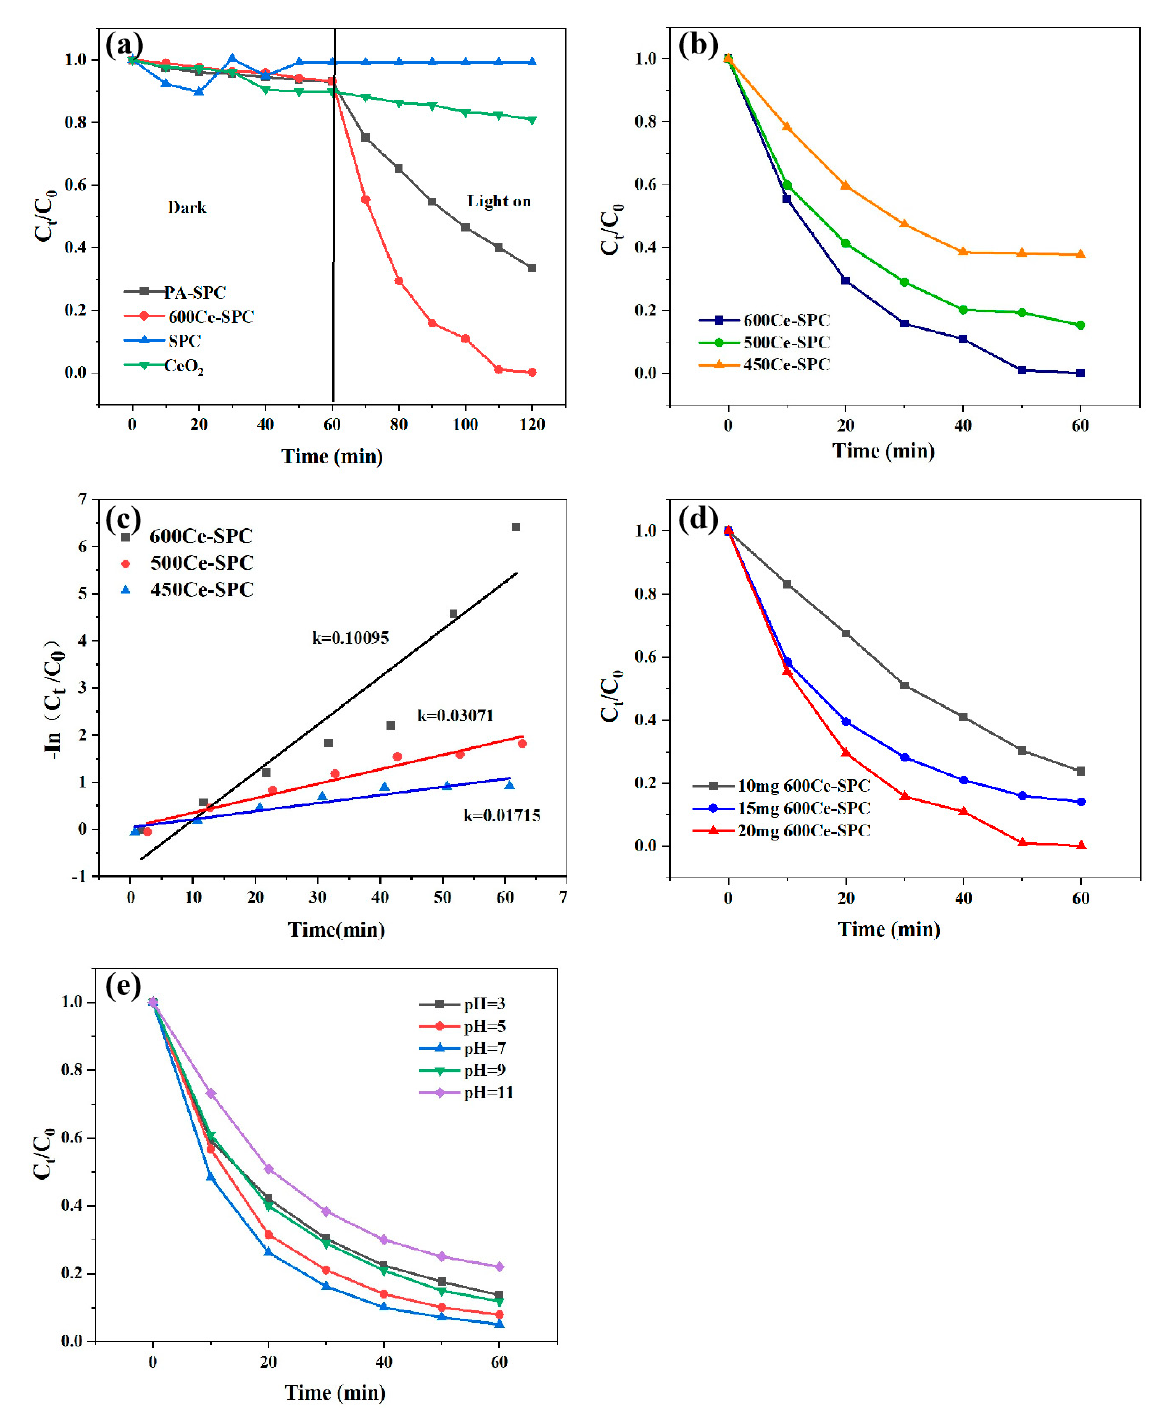
Figure 6. ( a ) Photocatalytic adsorption − degradation performance of SPC, PA − SPC, CeO 2 and 600 ( a ) Photocatalytic adsorption–degradation performance of SPC, PA–SPC, CeO 2 Ce − SPC ( b ) Photocatalytic activity of the photodegradation of TC for 60 min by 450 Ce − SPC/500 and 600 Ce–SPC ( b ) Photocatalytic activity of the photodegradation of TC for 60 min by Ce − SPC/600 Ce − SPC. ( c ) Secondary kinetics of photodegradation of TC for 60 min by 450 450 Ce–SPC/500 Ce–SPC/600 Ce–SPC. ( c ) Secondary kinetics of photodegradation of TC for 60 min Ce − SPC/500 Ce − SPC/600 Ce − SPC. ( d ) Photocatalytic performance of different catalyst dosages of by 450 Ce–SPC/500 Ce–SPC/600 Ce–SPC. ( d ) Photocatalytic performance of different catalyst dosages 600 Ce − SPC, ( e ) E ff ect of pH on photocatalytic experiment by 600 Ce − SPC. of 600 Ce–SPC, ( e ) Effect of pH on photocatalytic experiment by 600